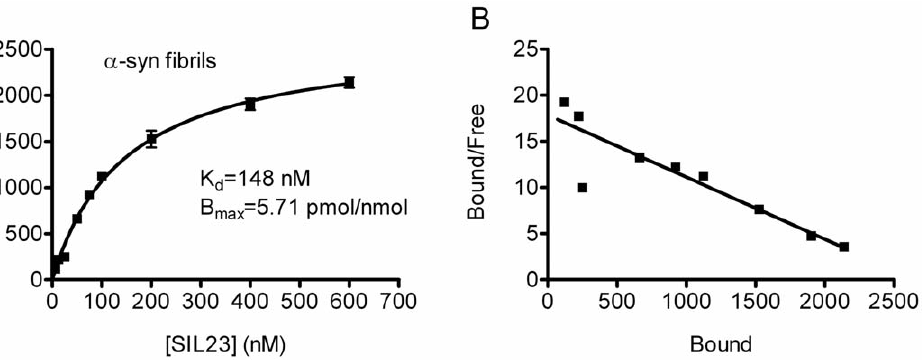
Figure 2. The radioligand [ 125 I]SIL23 binds recombinant a -syn fibrils with a K d of 148 nM. Fibrils prepared from recombinant a -syn were incubated with increasing concentrations of [ 125 I]SIL23. Nonspecific binding was determined in parallel reactions utilizing 50 m M ThioT as competitor. A representative plot of specific binding versus [ 125 I]SIL23 concentration is shown in A . Data points represent mean + / 2 s.d. (n=3). The data was analyzed by curve fitting to a one-site binding model using nonlinear regression. The K d value was determined by fitting the data to the equation Y=B max *X/(X + K d ). Scatchard analysis of binding is shown in B . Similar results were obtained in more than three independent experiments.